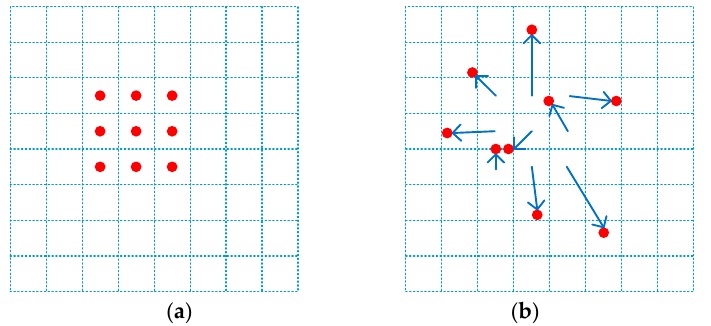
Figure 5. ( a ) is regular convolution operator. ( b ) is deformable paper operator.